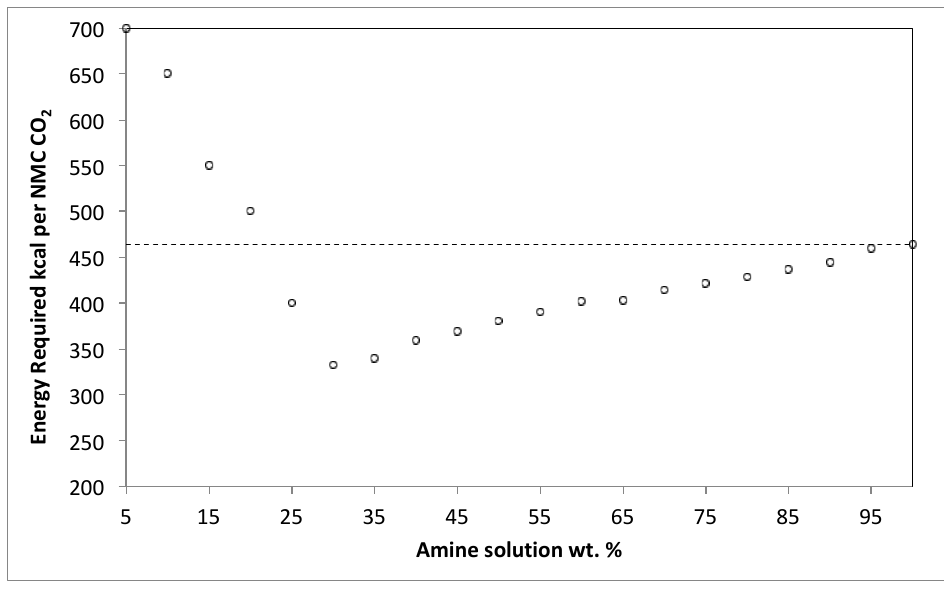
Figure 9. Amount of energy required per NMC of CO 2 removal. Dotted line presents the conventional process working with amine solution. The circles present the data directly obtained by